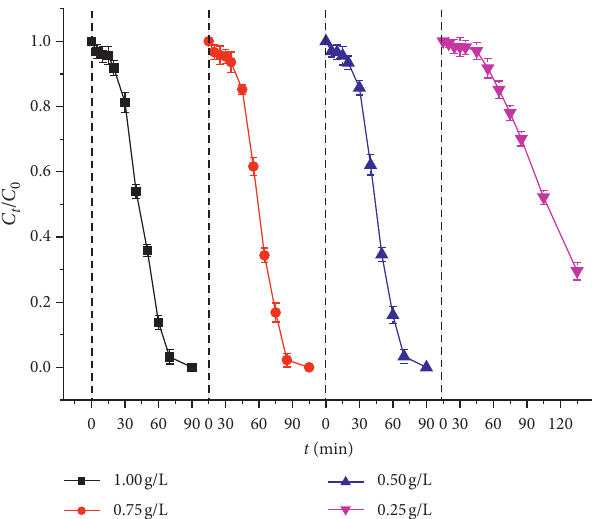
Figure 10: MO decomposition by H 2 O 2 on MIL-53(Fe) at different Figure 8: MO degradation by UV/H catalyst dosages (experimental conditions: 40mg/L MO; 2 O 2 over the MIL-53 catalyst 0.192MH 2 O 2 ; temperature 30 ° C; UV at different solution pH (experimental condition: 0.5g/L of the catalyst; 40 mg/L MO; 0.192M H 2 O 2 ; temperature 30 ° C; UV radiation).